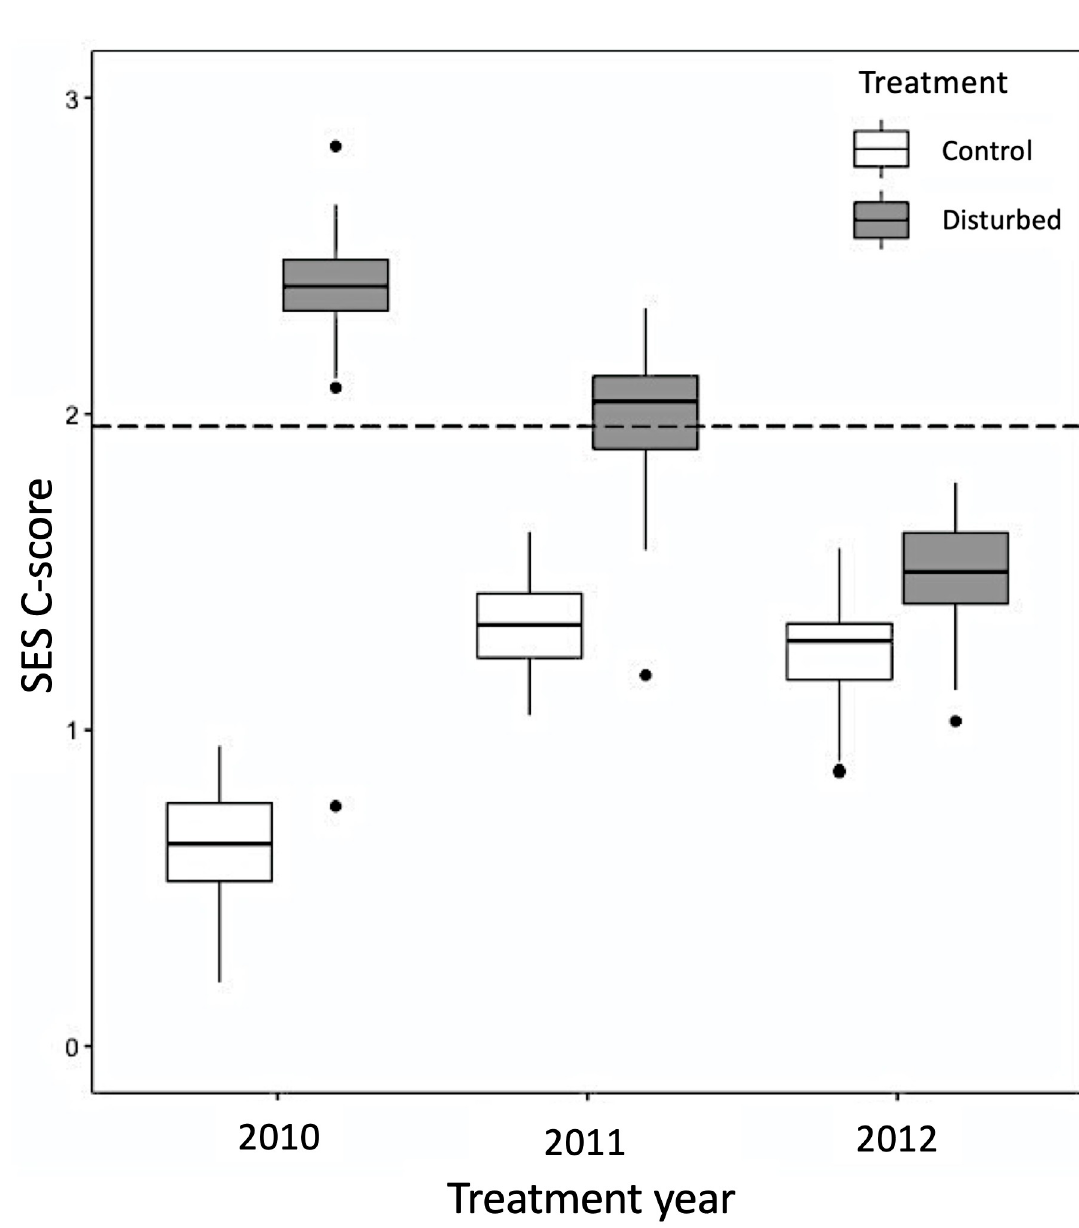
Fig 4. SES C-score graphs for each treatment type at the Arboretum site. Boxplots representing the median and interquartile range of the logged SES C-scores for each treatment type at the Arboretum, across treatment years. The dashed line represents a z-score of 1.96, above which negative co-occurrence patterns are generally accepted as being higher than expected by chance. The whiskers represent 95% confidence intervals for a stability estimate of the SES for the C-score. Variance within treatment and year represents SES values when each plot is removed from